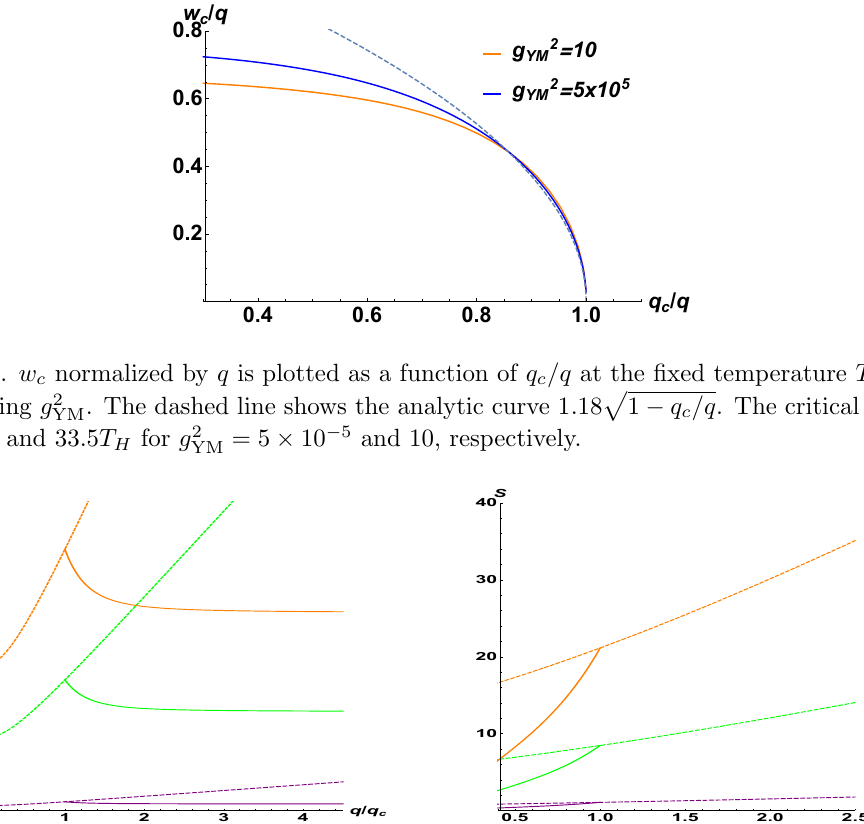
Figure 2 . The normalized Bekenstein-Hawking entropy S = 2 (cid:25)=z h is plotted in units of 2 (cid:25)=(cid:20) 2 (= c 2 d = 6) when g 2 = 10. The dashed line gives the entropy in the AdS 3 charged black hole. The YM solid line gives the entropy in the condensed phase T > T c or q < q c . Left: the normalized BH entropy is plotted for (cid:12)xed temperature as a function of q=q c = q= (33 : 5 T H ). Orange, green, and purple curves denote the normalized entropy for T H = 3 = 10, 3 = 20, 1 = 100, respectively. Right: the normalized entropy S = 2 (cid:25)=z h is plotted for (cid:12)xed charges as a function of T H =T c . Orange, green, and purple curves denote the normalized entropy for q = 10, 4, and 1 = 2,